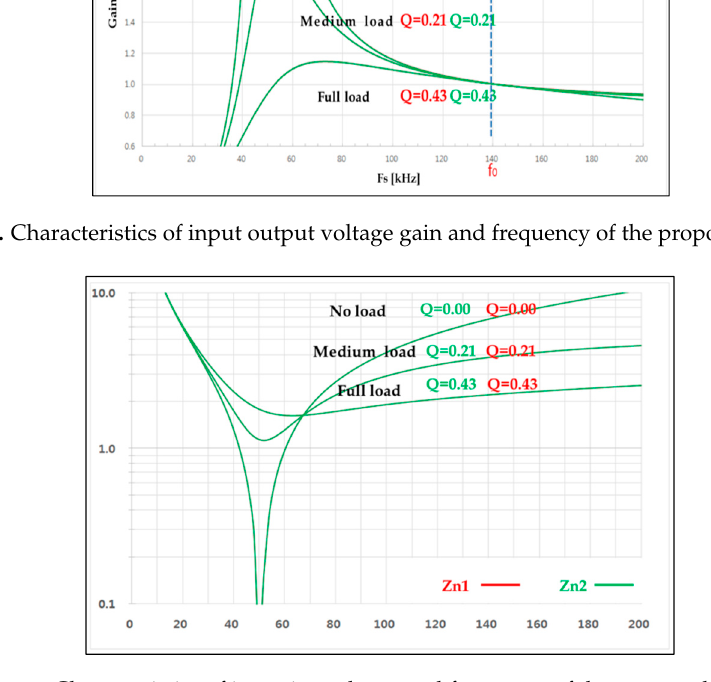
Figure 17. Characteristics of input impedance and frequency of the proposed converter.